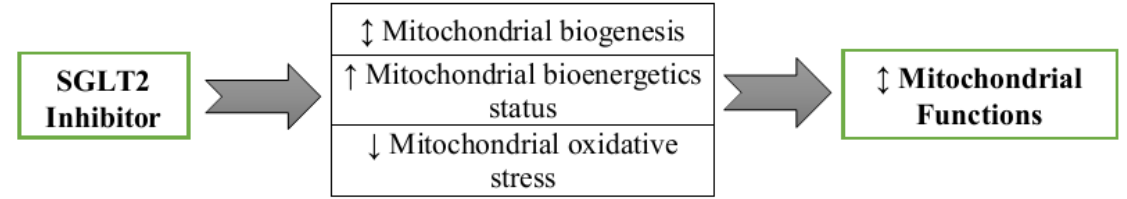
Figure 4: SGLT2 inhibitors modulate mitochondrial function through at least three